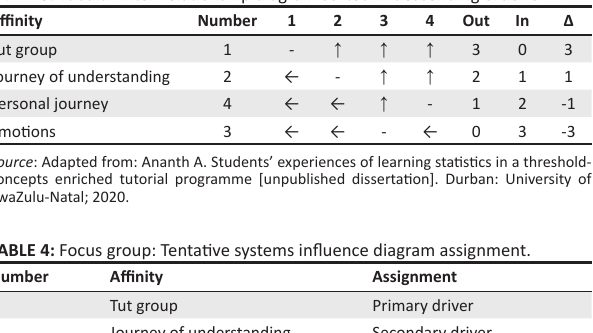
FIGURE 1: Cluttered systems influence diagram.